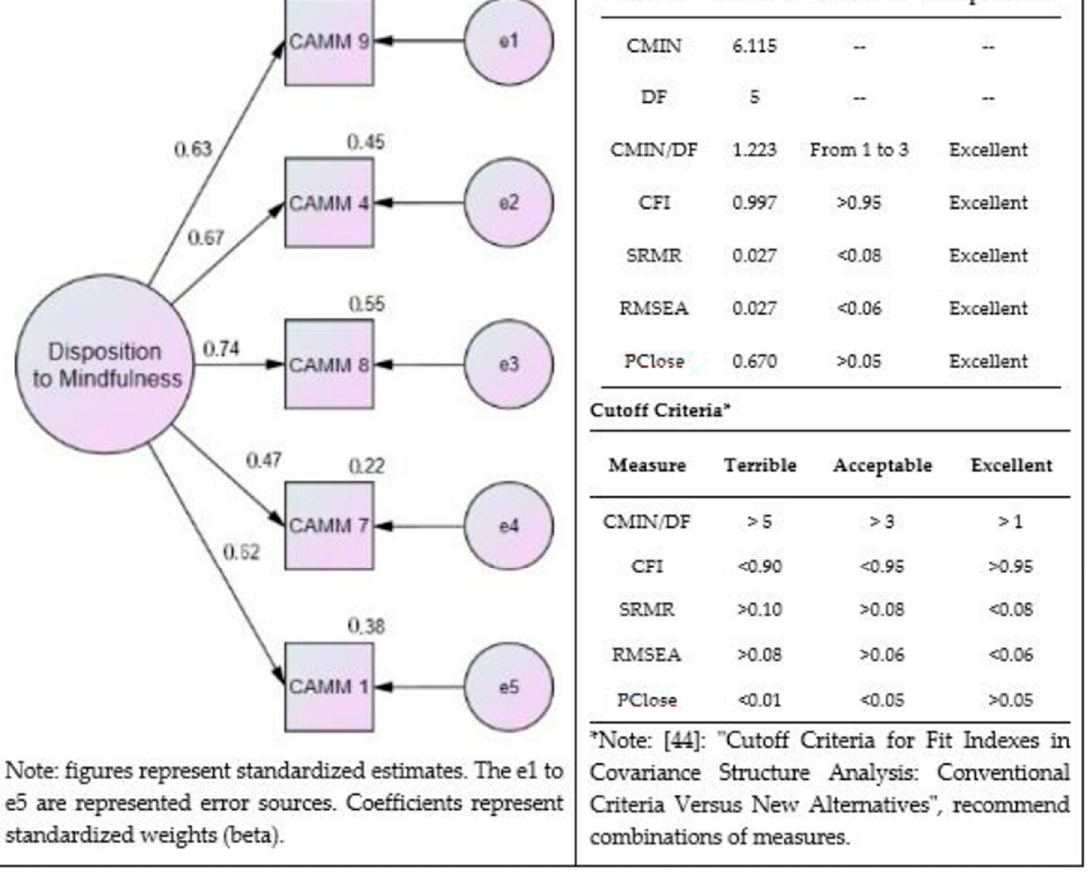
Figure 2. Confirmatory factor analysis (CFA) in Andalusian sample. Final version proposed as Spanish 5-items